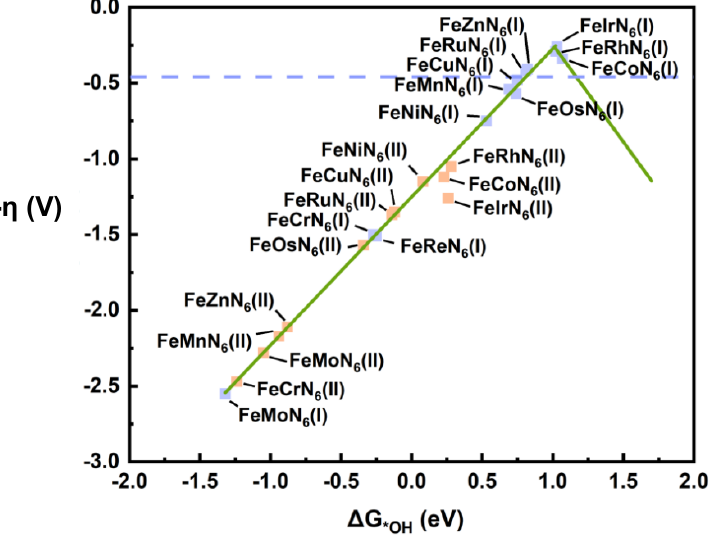
Figure 5. Volcano plot of −η related to ΔG *OH for FeMN 6 (I) and FeMN 6 (II).